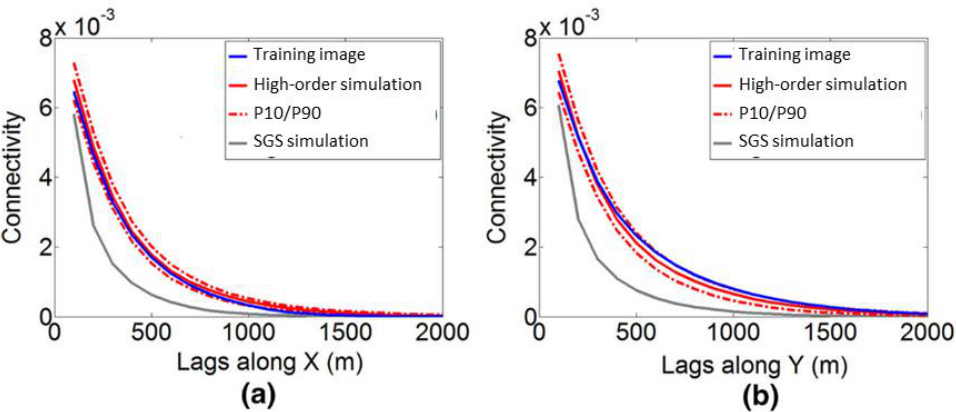
Figure 1. Connectivity of high-grades along X ( a ) and Y ( b ) direction, calculated for the 99th percentile from the data distribution. Figure adapted from Minniakhmetov et al. [49]. P10 and P90 represent the 10th and 90th percentiles of the reported values, respectively.